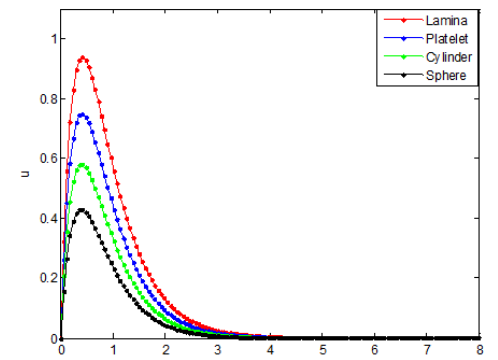
Figure 9. Effect of nanoparticle shape on velocity distribution of the nanofluid